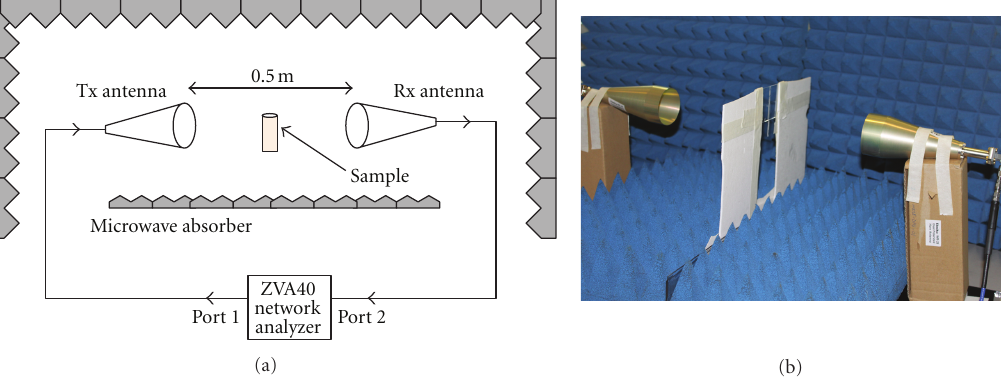
Figure 3: Measurement setup, (a) description, (b) picture of the setup.